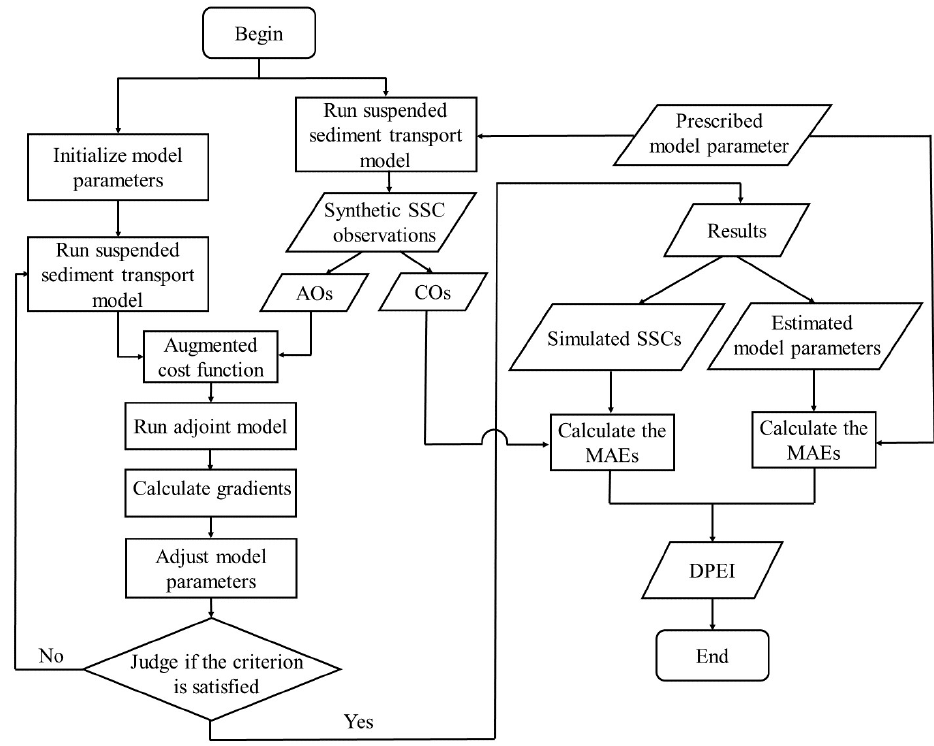
Figure 3. Flow chart of the twin experiments in this study.